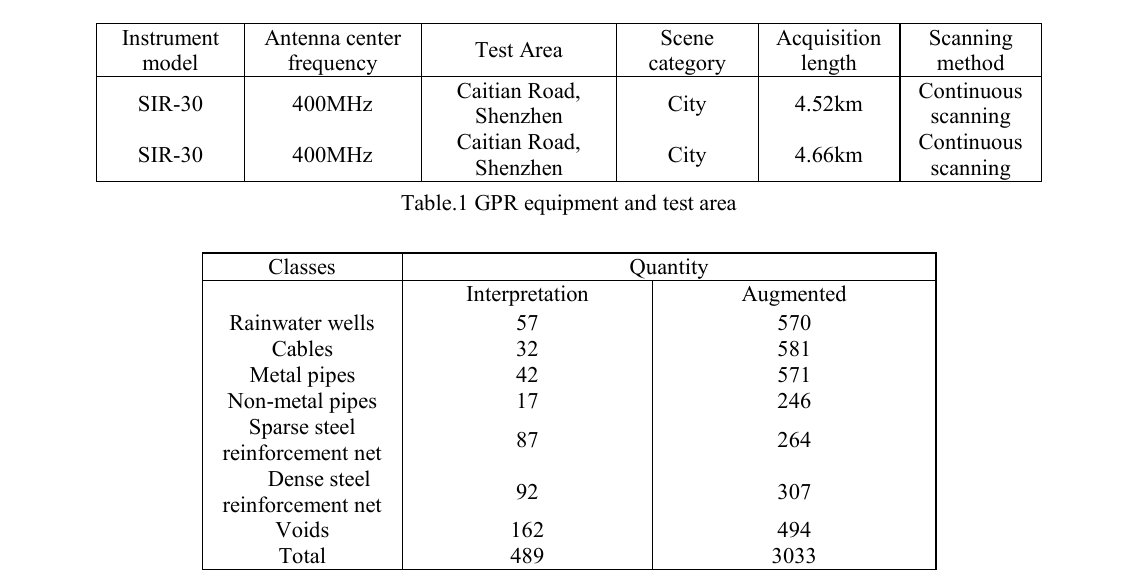
Figure 2. The line chart of Loss value